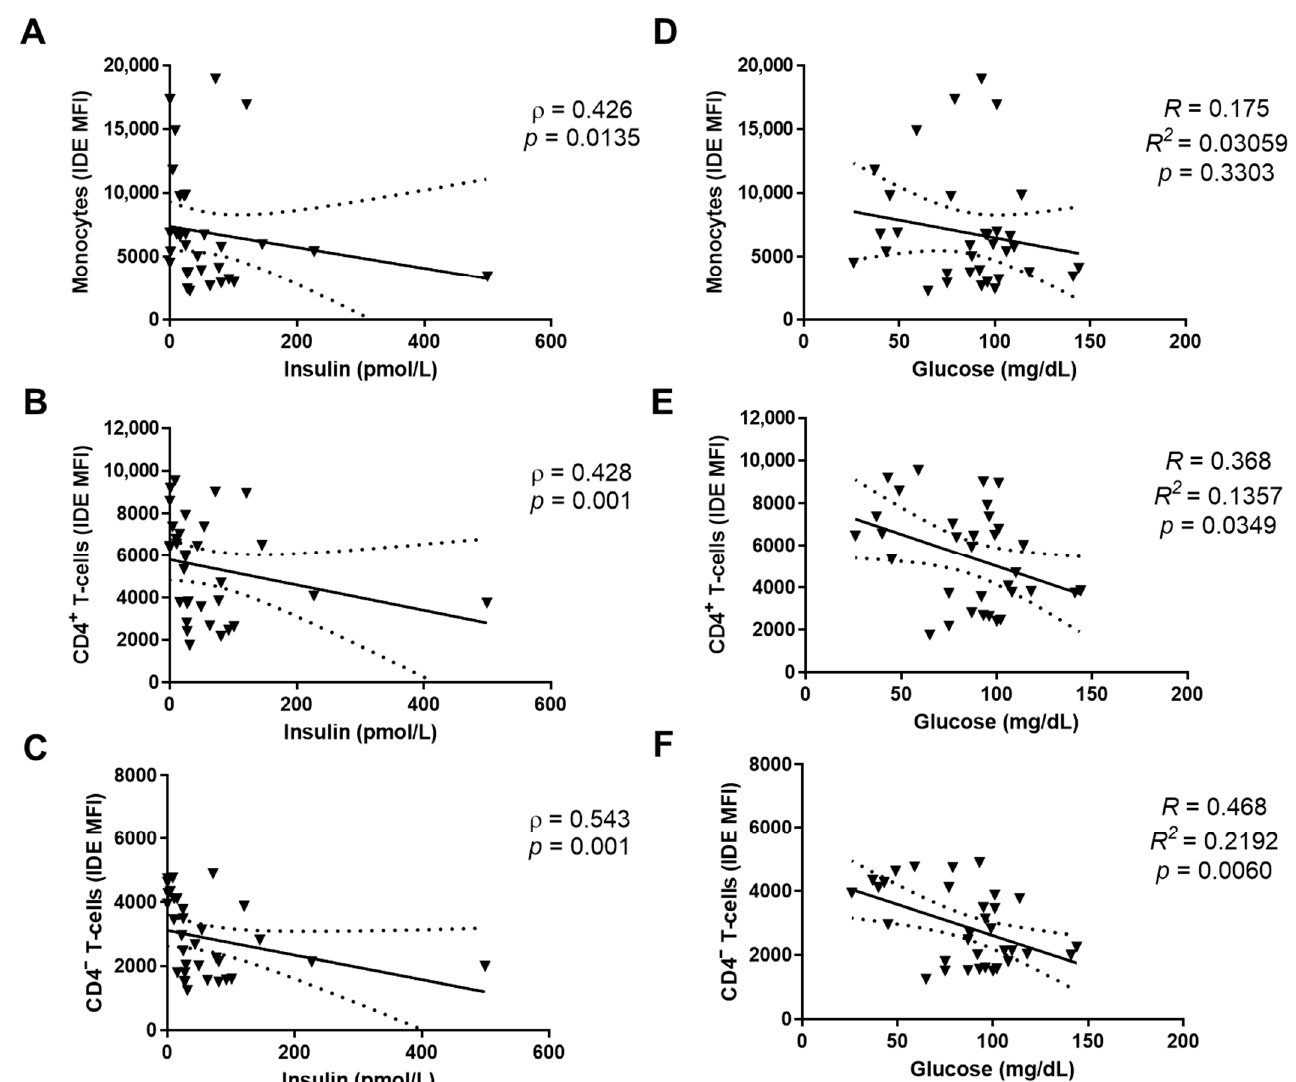
Figure 5. Glucose and insulin levels associated with IDE surface expression in human PBMCs from COVID-19 and post-COVID-19 patients. Bivariate analyses were performed using data from COVID-19 and post-COVID-19 patients. Correlations are shown between insulin and monocytes ( A ), CD4 + T-cells ( B ), and CD4 − T-cells ( C ). The Spearman’s correlation ( ρ ) and the statistical significance ( p ) are indicated in Figure 5. Correlations are shown between glucose and monocytes ( D ), CD4 + T-cells ( E ), and CD4 − T-cells ( F ). The R 2 and the statistical significance ( p ) are indicated.